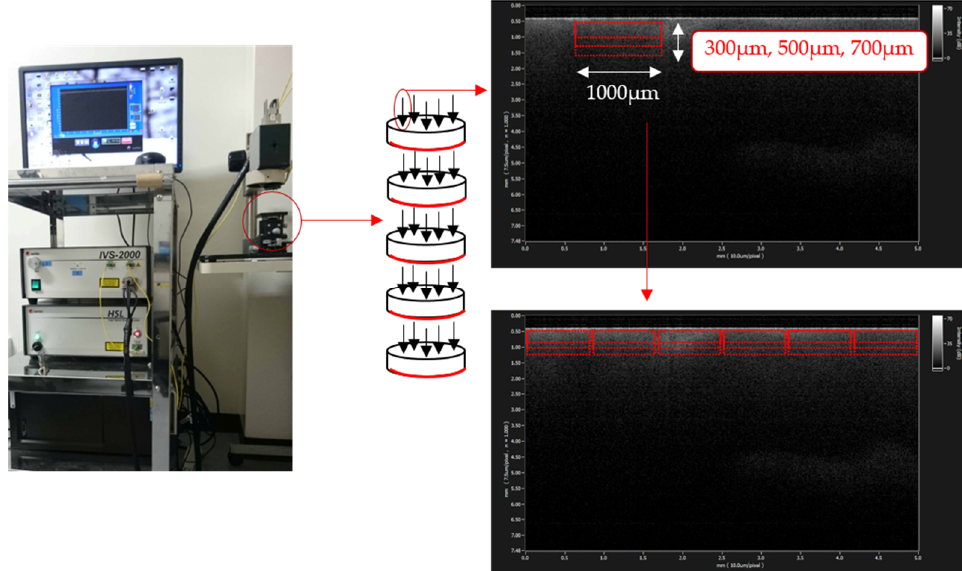
Figure 2. Setting the region of interest (ROI). Five locations were randomly selected on each of the five dentin discs for 25 points per group. A ROI width of 1000 µm × optical depth of 300, 500, or 700 µm from the surface of the specimen discs was set on the obtained SS-OCT images. The six areas of ROI at each depth were set in one image. The integrated signal intensity and signal attenuation coefficient in these ROIs were calculated.